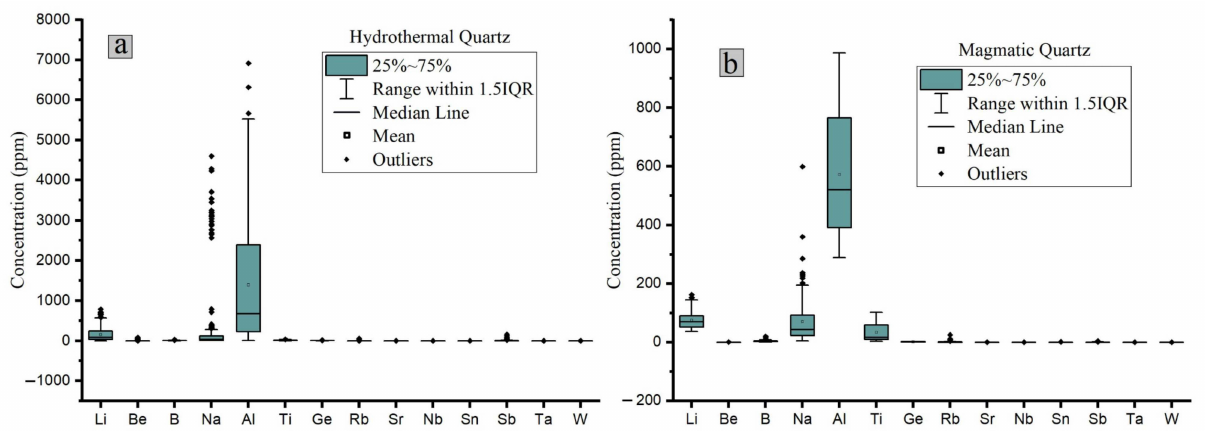
Figure 10. Representation of the correlation between magmatic and hydrothermal quartz. ( a ) Representing the trace elements concentration in hydrothermal quartz; ( b ) representing the magmatic quartz trace elements